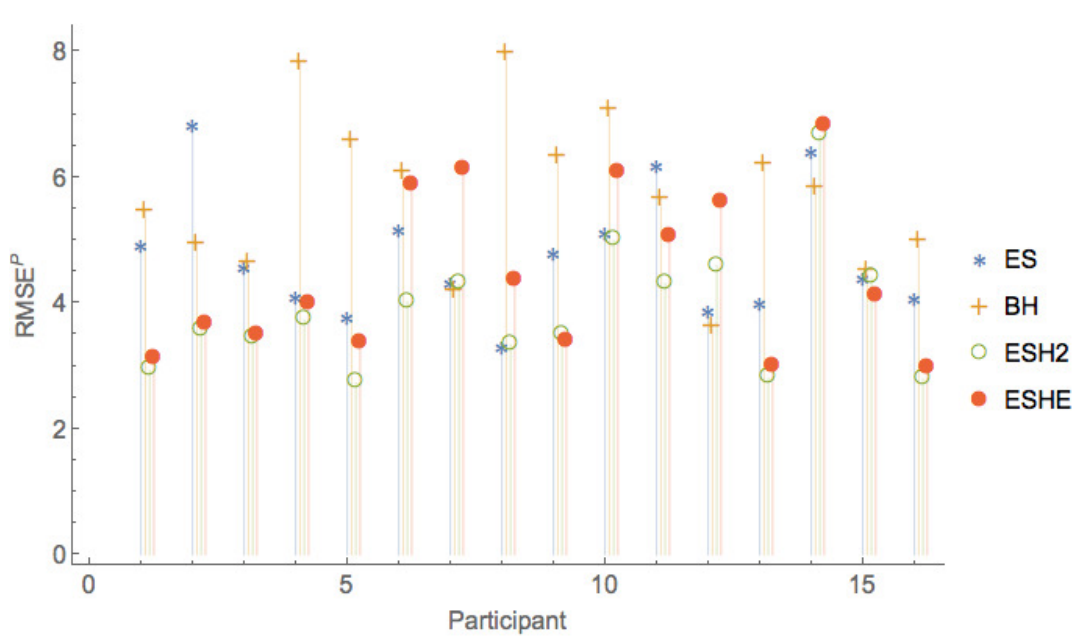
Figure 8. Comparison of leave-one-period-out LOOCV RMSE of selected models for Session 1.